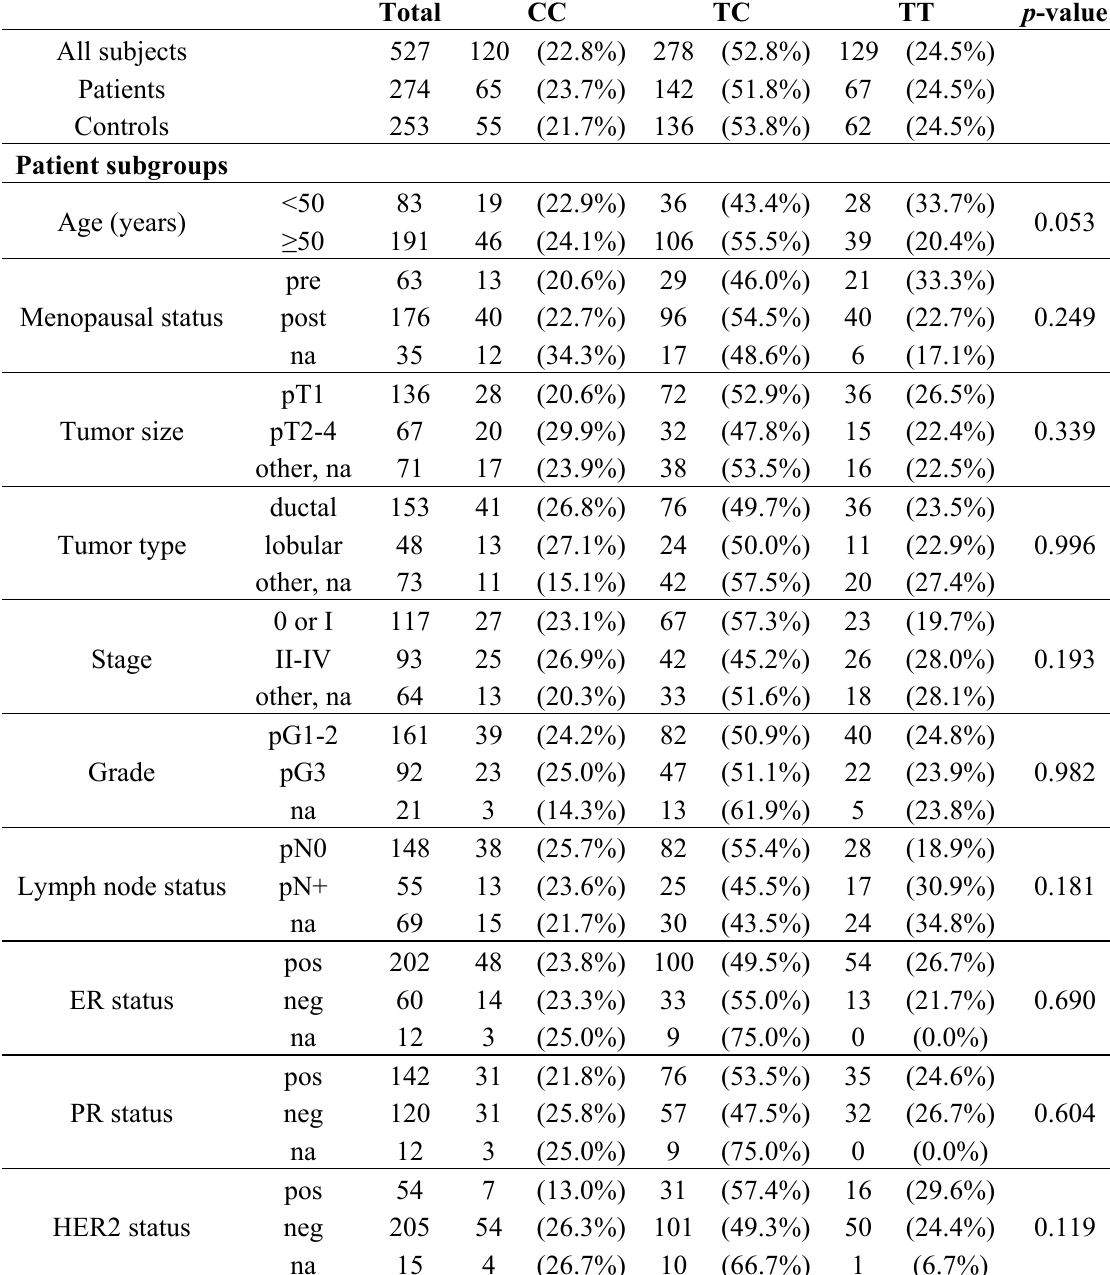
Table 1. Clinical characteristics of the study population, and frequency of the CYP19 rs10046 genotypes in the indicated